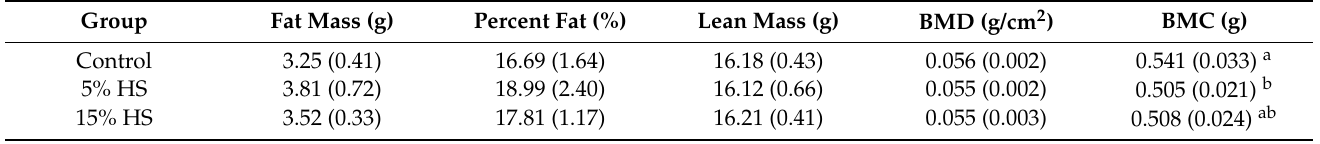
Table 3. Body composition at end of experiment.